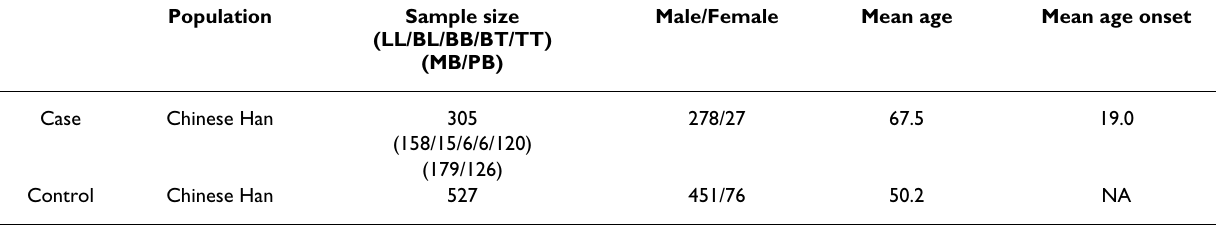
Table 1: Characteristics of the study population of 305 cases and 527 controls